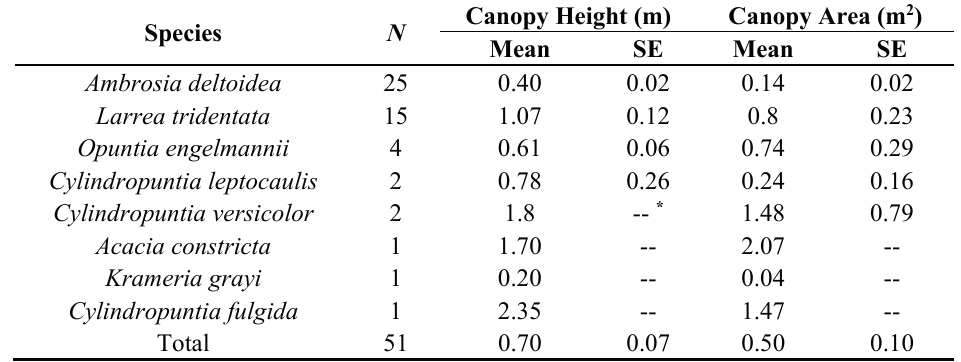
Figure 1. ( a ) photo of vegetation in the study area; and ( b ) map of surveyed plant canopies from the 2012 census of plot 4 at the Desert Laboratory in the Sonoran Desert; Individual plants of the three dominant species are identified in (b). Table 3. Canopy height and area by predominant species on plot 4 at the Desert Laboratory in Tucson, Arizona measured by total station survey (April